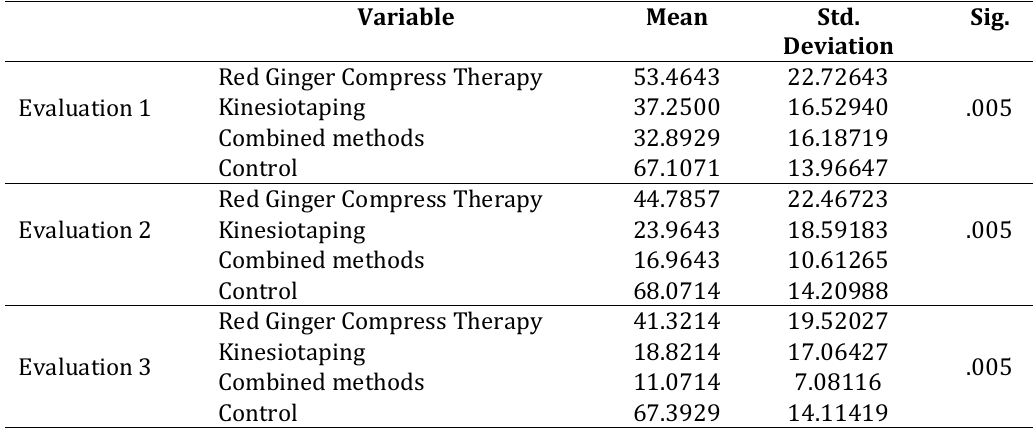
Discrepancy between intervention group and control group Variable Mean Std. Deviation